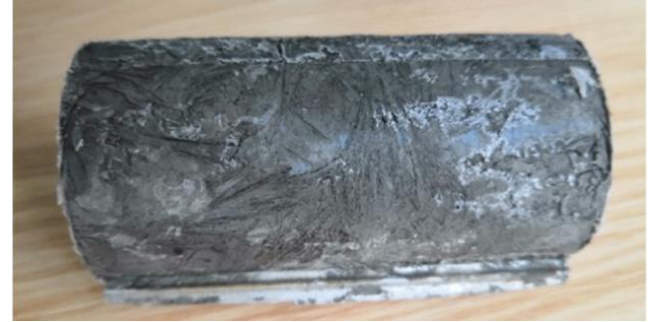
Figure 1. Photograph of the freezing specimen.